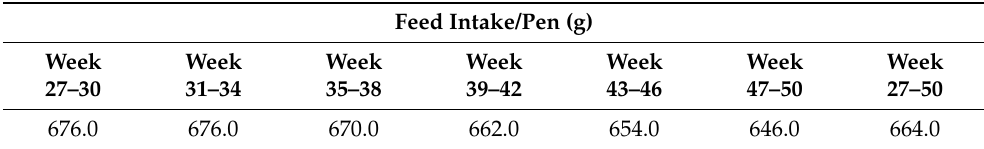
Table 1. Feed intake of breeder hens from 27 to 50 weeks of laying.